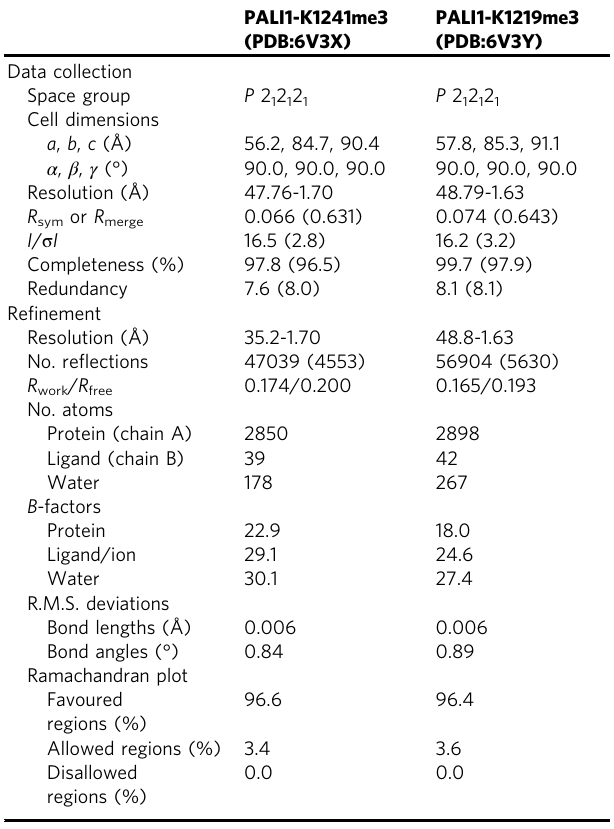
Table 1 X-ray crystallography data collection and re fi nement